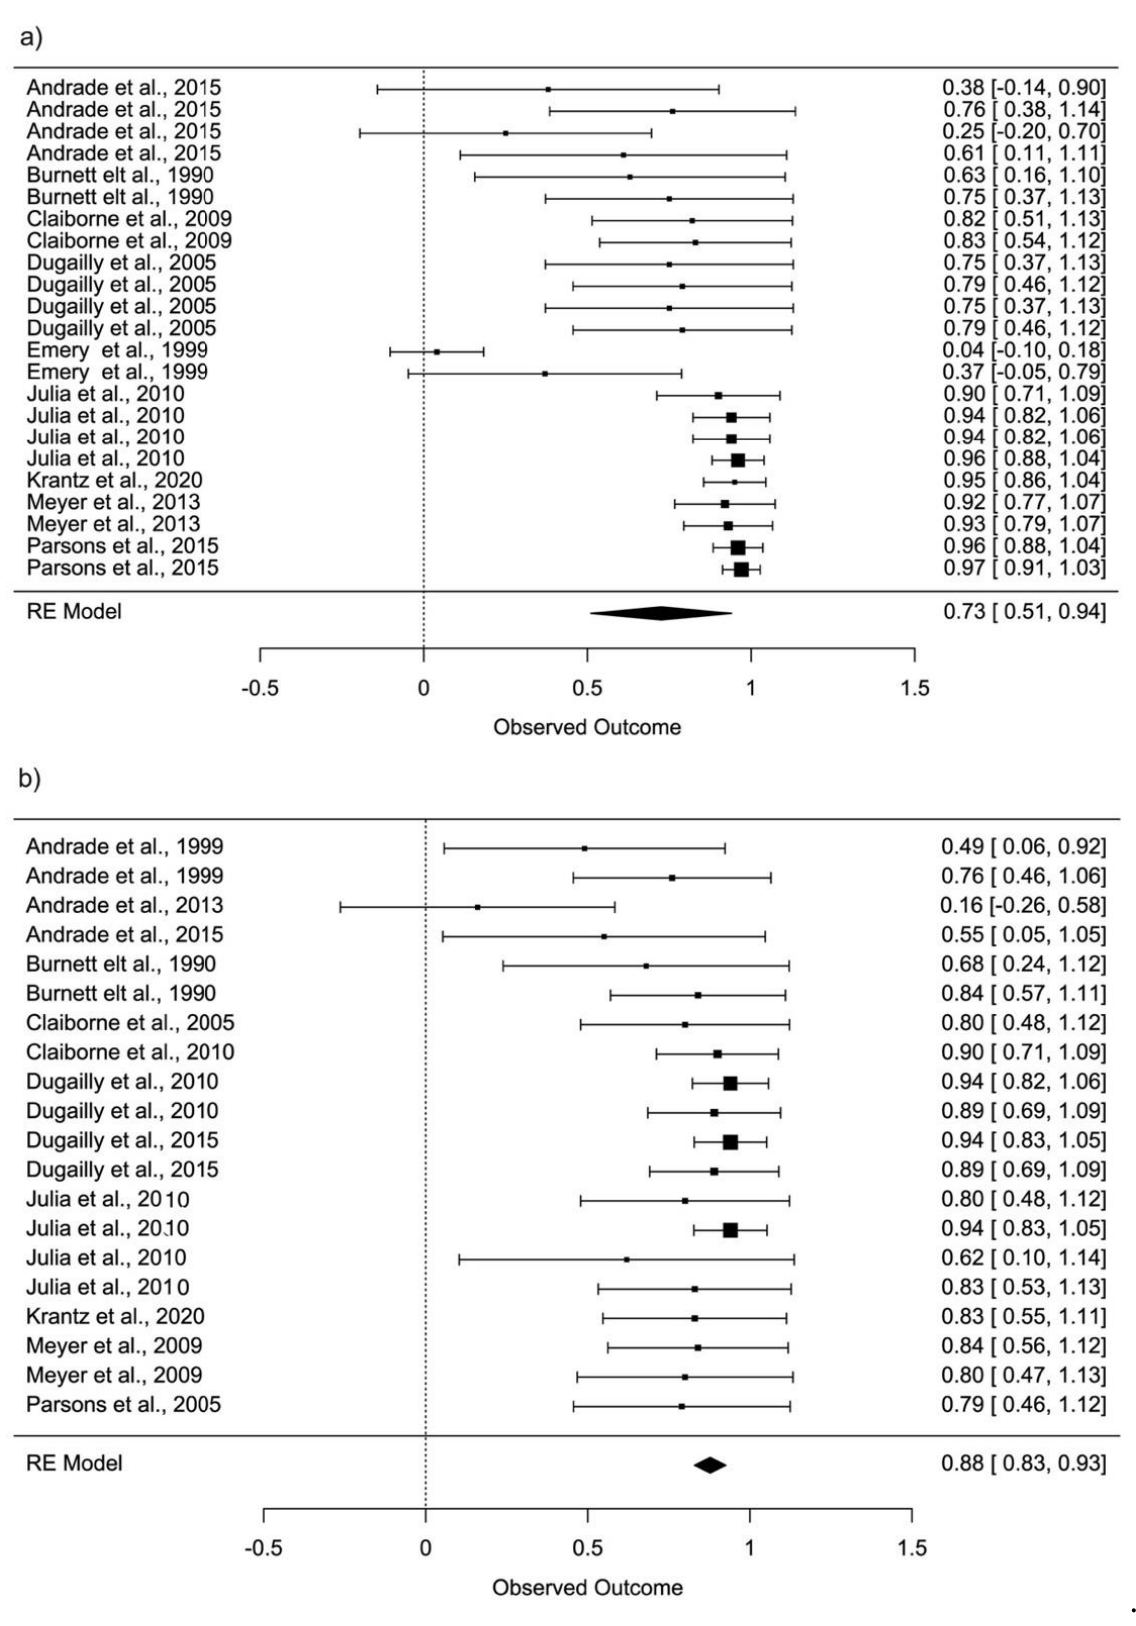
Figure 2. Forest plot, 95% confidence interval (CI95%) for reliability hip flexion ( a ) and reliability hip extension ( b ).